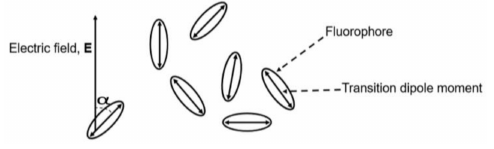
Figure 1. Schematic representation of